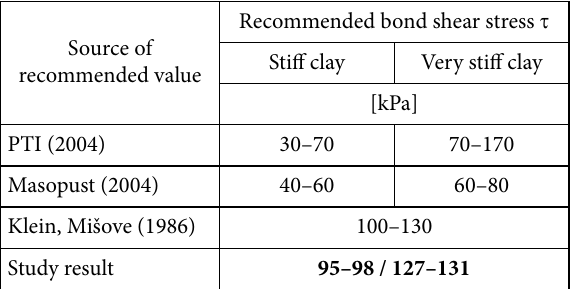
Table 5. Comparison of study results – stipulated bond shear stress τ , with values available in